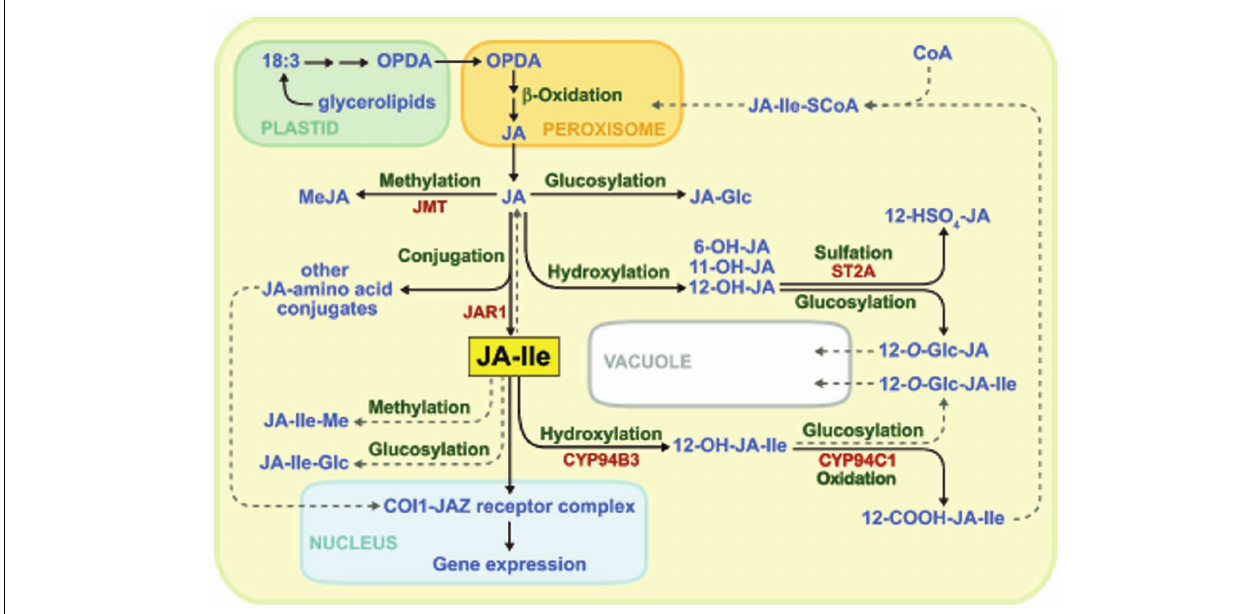
FIGURE 1 | Major pathways for the biosynthesis and catabolism of JA-Ile. Confirmed biochemical pathways and products are indicated by solid lines, whereas dashed lines denote hypothetical pathways for which there is currently little or no evidence. See text for details.